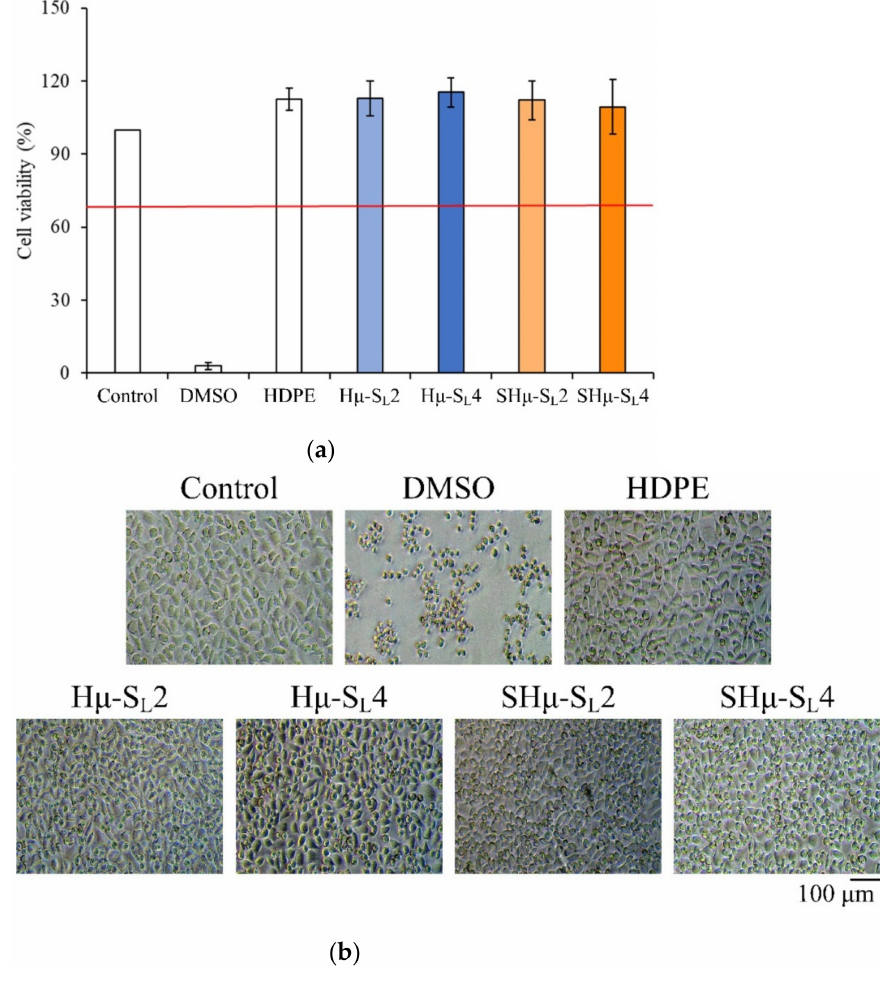
Figure 7. Extracts of different hydrogel scaffolds were used to culture L929 cells for one day: ( a ) quantitative results of cytotoxicity ( n = 6) and ( b ) qualitative analysis of